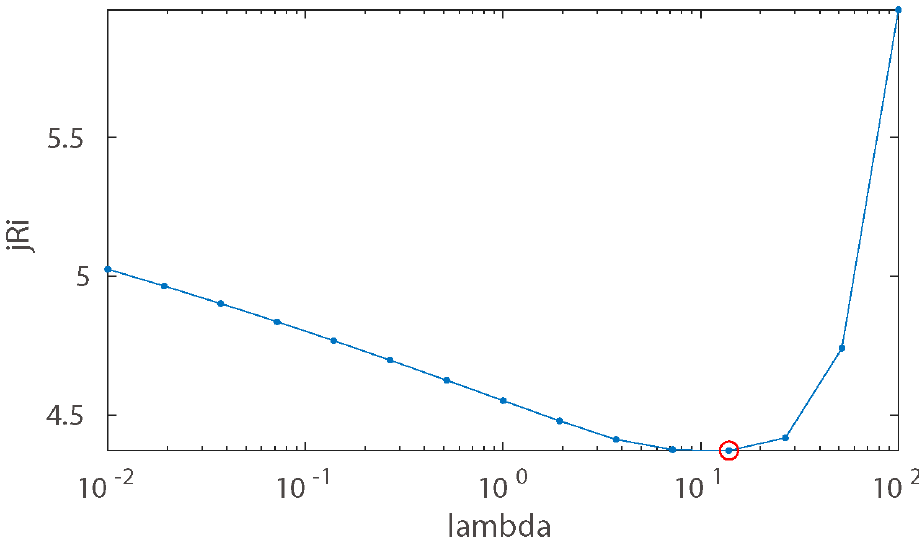
Figure 5. The jRi curves for coseismic slip inversion. Red cycle on jRi curves is the corresponding jRi and lambda values used to weight the smoothing of coseismic slip inversion. The coseismic slip inversion results on a northwest dipping fault configuration indicate that the 2021 Nagqu earthquake ruptured on a fault structure with a length of ~15 km and a width of ~12 km (Figure 6). Coseismic slip mainly concentrates at 2 − 12 km in depth, and the maximum slip (~0.3 m) is located at a depth of ~8 km (Figure 6a). The coseismic fault slip reveals the comparable components of dip-slip and sinistral slip (Figure 6b,c) with a mean rake angle of − 56 ◦ within the slip zone (>0.1 m). This illustrates that the 2021 Nagqu earthquake occurred within local transtensional tectonics. The absence of remarkable coseismic slip in shallow depth (0 − 2 km) suggests that the Nagqu earthquake may not have ruptured the surface (Figure 6). The predicted displacements from the best-fitting model explain both the ascending and descending coseismic observations well, with a Root Mean Square of ~0.7 cm (ascending) and ~0.5 cm (descending), respectively (Figure 2). The remaining residuals can be potentially explained by the residual topography and atmospheric artifacts. Assuming the average shear moduli of 33 GPa in the epicenter region [29], we calculated a geodetic moment as ~4.5 × 10 17 Nm, corresponding to Mw 5.7. Our estimated coseismic slip distribution and moment magnitude are comparable with those reported in previous studies using the geodetic or seismological dataset (Table